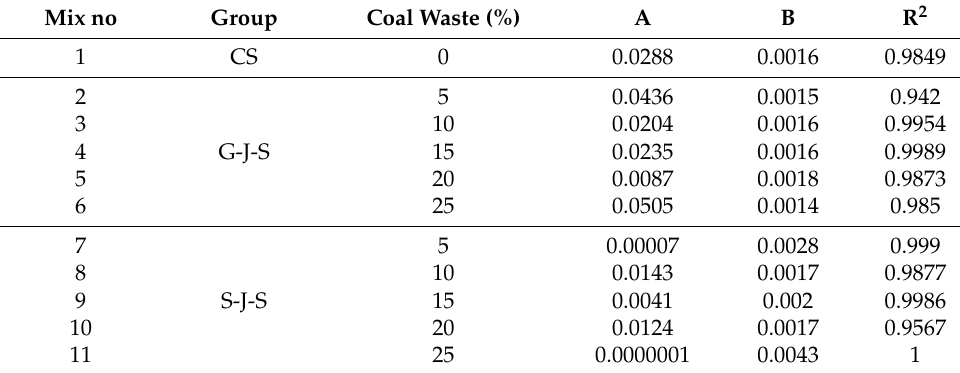
Table 6. Exact values of empirical constants and correlation coefficients in UPV–compressive strength relationship.